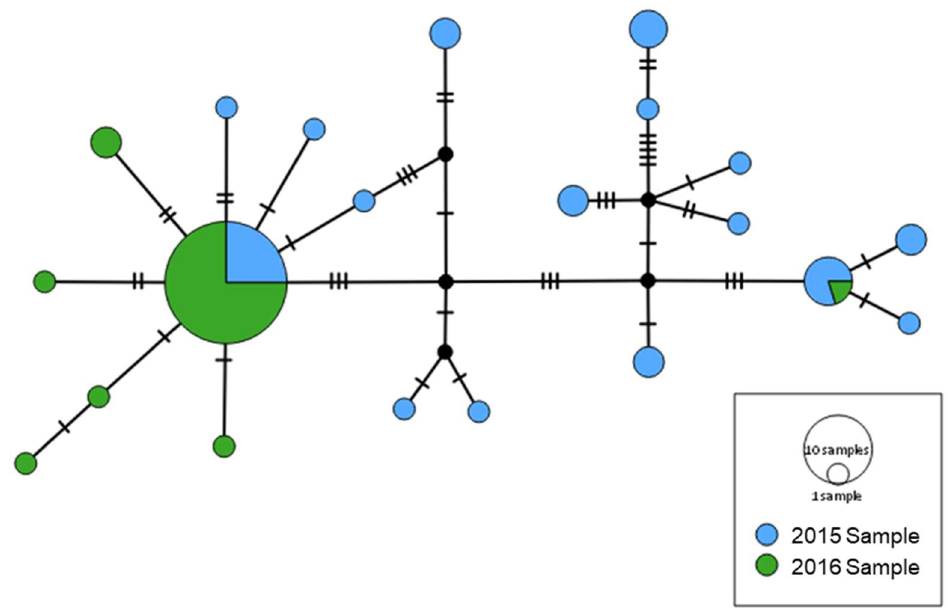
Figure 3. Haplotype network from mtDNA concatenated sequences of control region (CR), cytochrome c oxidase subunit I gene (COI) and cytochrome c oxidase subunit II gene (COII). Circles sizes are proportional to the number of sequences representing the haplotype.